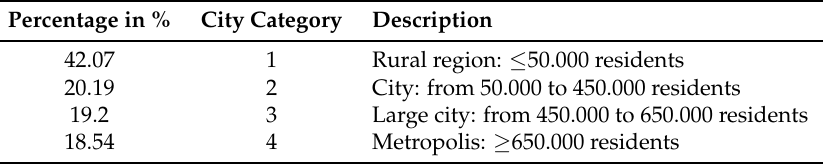
Table 8. Distribution of vehicles among the city categories based on MiD.